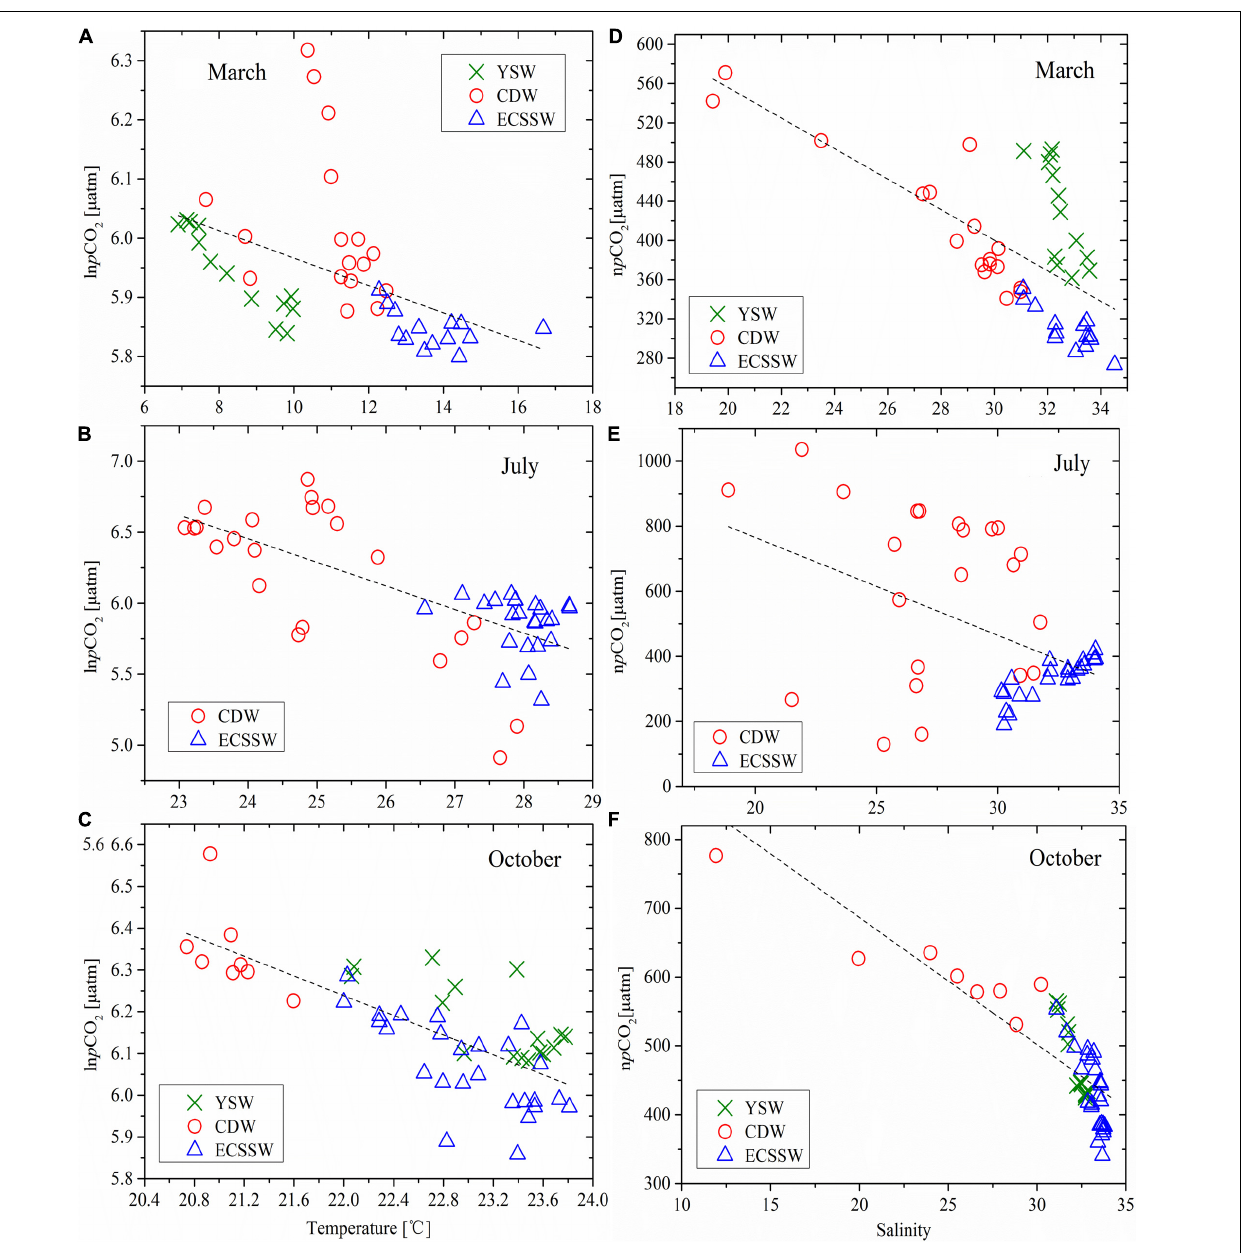
FIGURE 7 | (A–C) ln p CO 2 versus temperature and (D–F) n p CO 2 versus salinity in March, July, and October, with the same water type zonings as Figure 2 . n p CO 2 was normalized to the average temperature of 11.07 ◦ C in March, 26.55 ◦ C in July, and 22.75 ◦ C in October. Dashed lines are the regression lines of ln p CO 2 /n p CO 2 with all